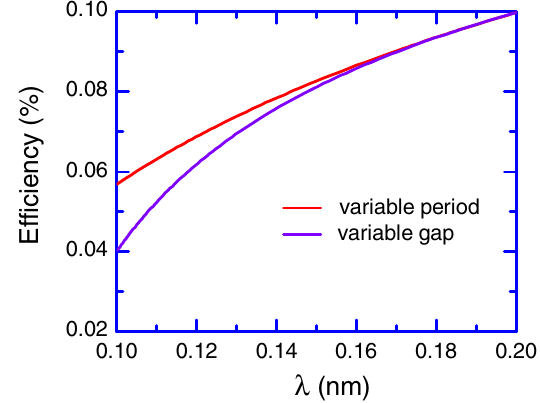
FIG. 12. The dependence of the FEL efficiency on the radia- tion wavelength.